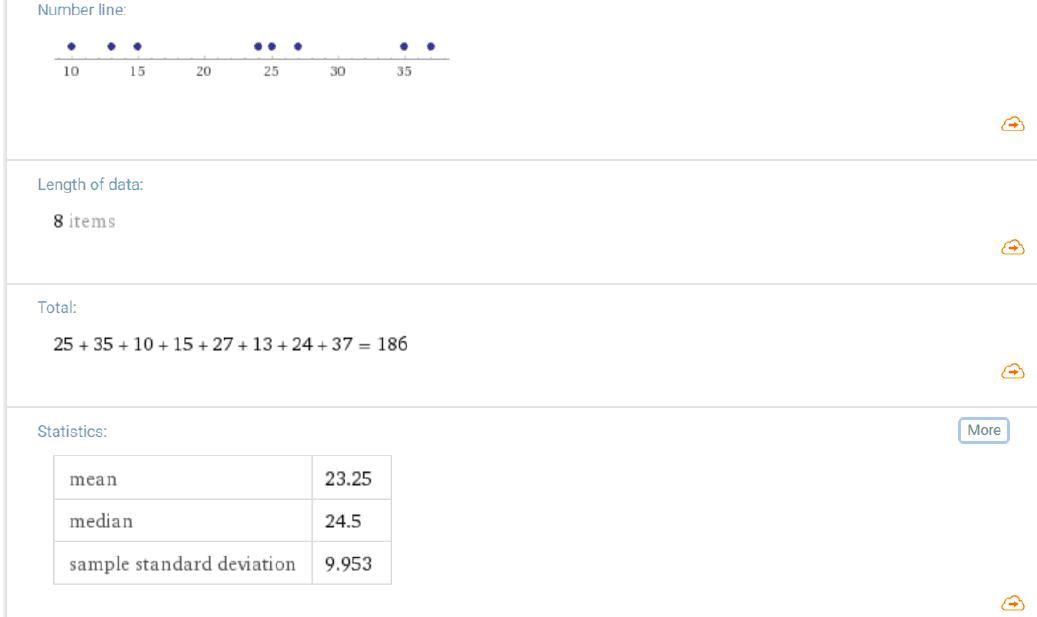
Figure 21: Presentation of paper